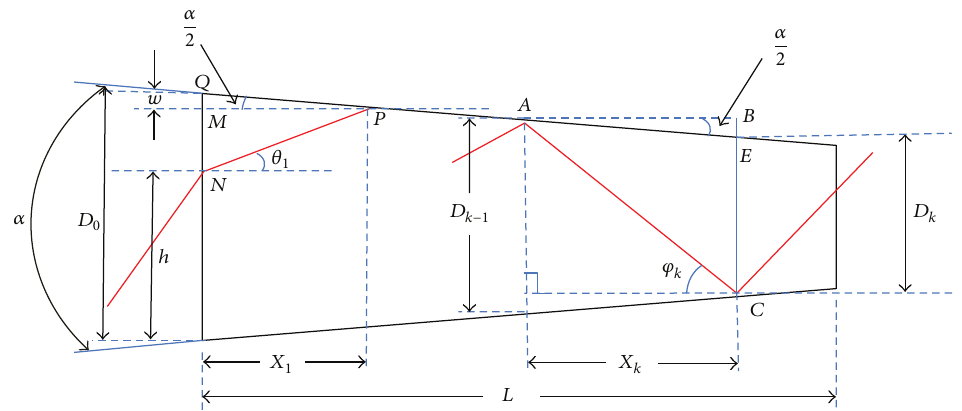
Figure 9: Total internal reflection of incident light in a CTPC at 𝑘 th reflection.